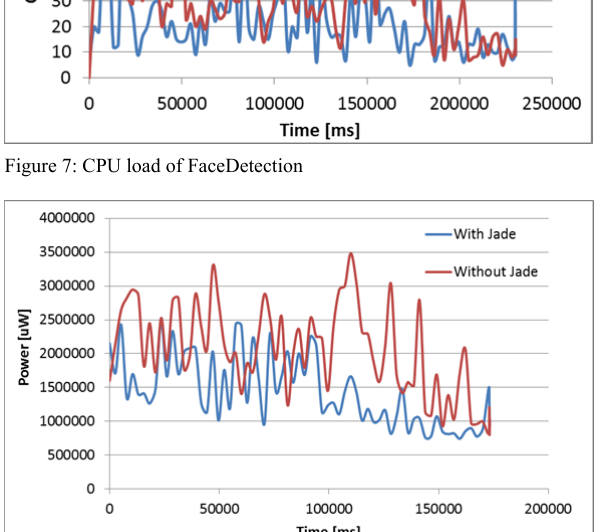
Figure 8: Power consumption of FindRoute